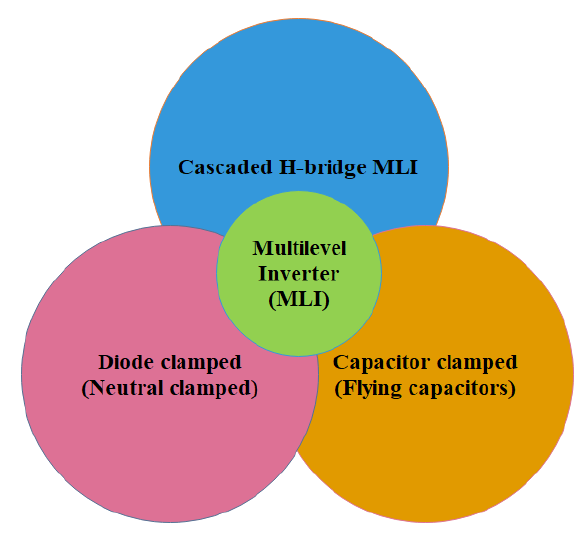
Figure 1. Basic classification of multilevel inverters (MLI).